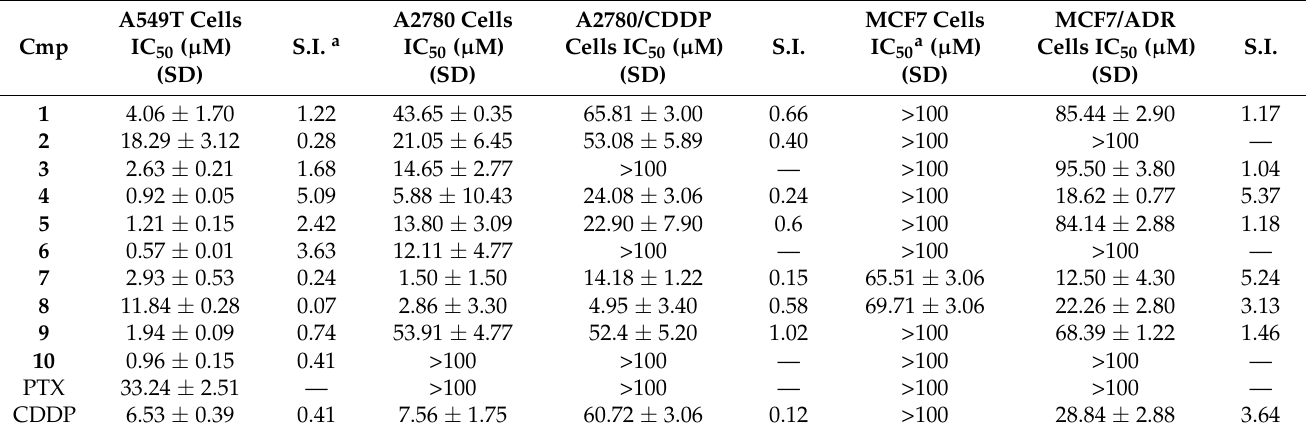
Table 1. Cytotoxicity of compounds 1 – 10 against wild-type and drug-resistant cancer cell lines with selectivity index (S.I.), compared to paclitaxel ( PTX ) and cisplatin ( CDDP ). Selectivity